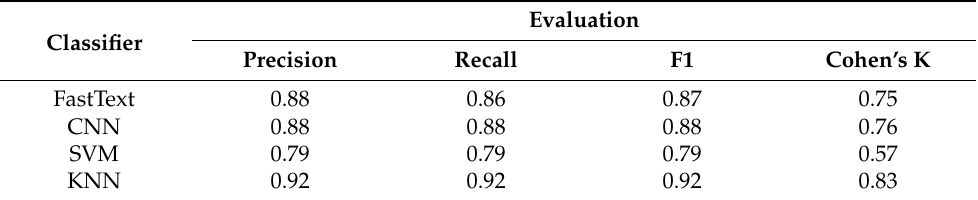
Figure 3. Graph of overall results of the validation set for all classifiers using a dataset of 10 6 samples.